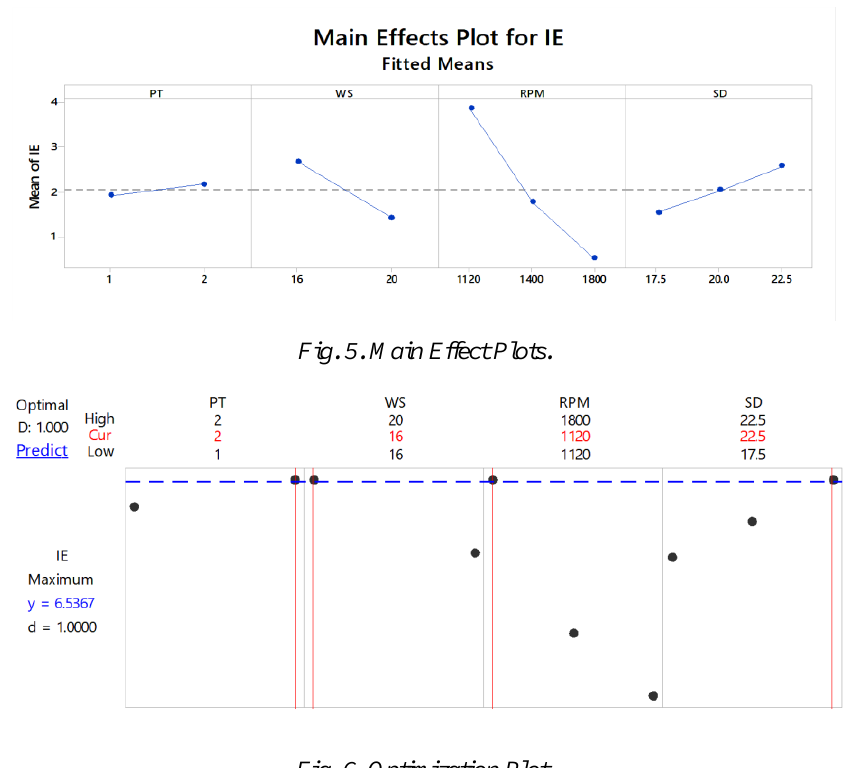
Fig. 6. Optimization Plot.